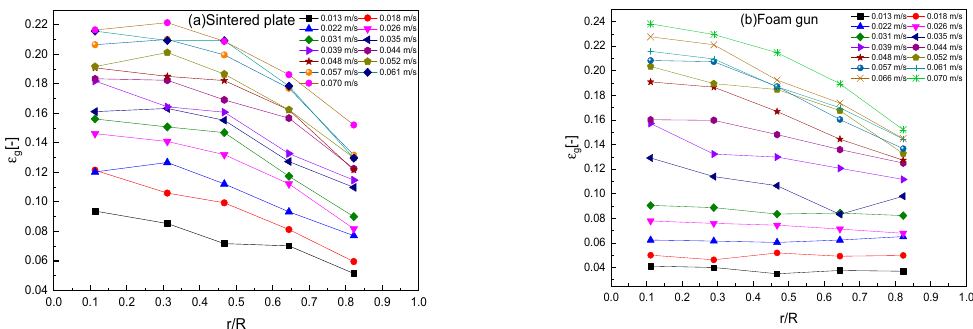
Figure 10. Radial gas holdup measured by the fiberoptic probe. ( a ) Sintered plate. ( b ) Foam